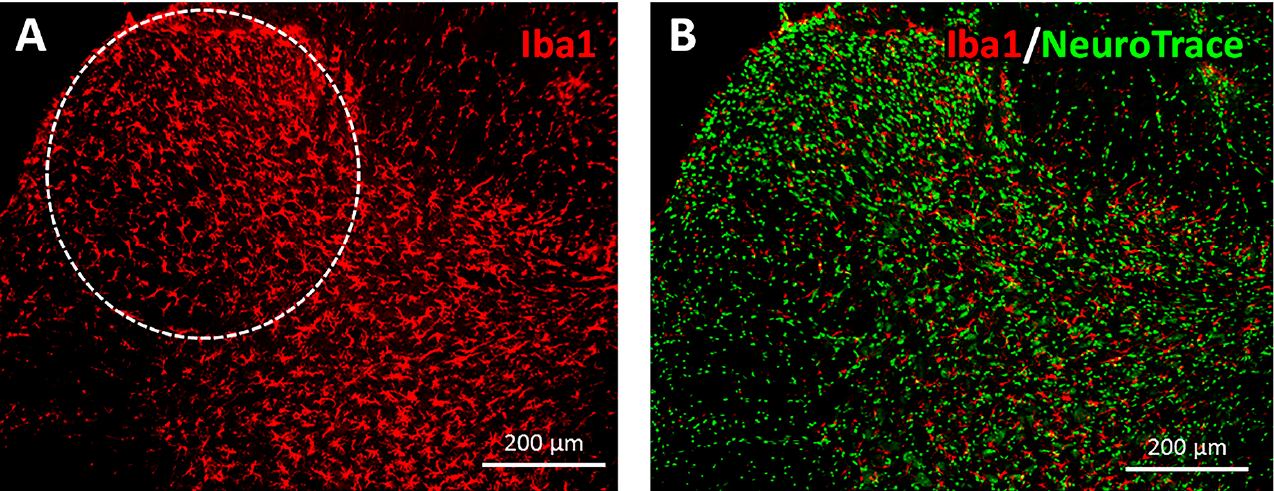
Figure 6. Immunostaining of microglia/macrophages in the dorsal horn in a transverse section of the lumbar-spinal-cord L2 segment using rabbit anti-Iba1 and sheep anti-rabbit Cy3 conjugated IgG antibodies at 12 weeks after SCI (image belongs to WBV28 group). Microglia/macrophages were found predominantly in the gray matter—involving both the ventral horn and dorsal horn—where they were in intimate spatial contact with the neuronal cell bodies ( B ), exposed with green immunofluorescence via counterstaining with NeuroTrace 500/525). The area of interest (AOI) of the dorsal horn is illustrated by a white dashed line ( A